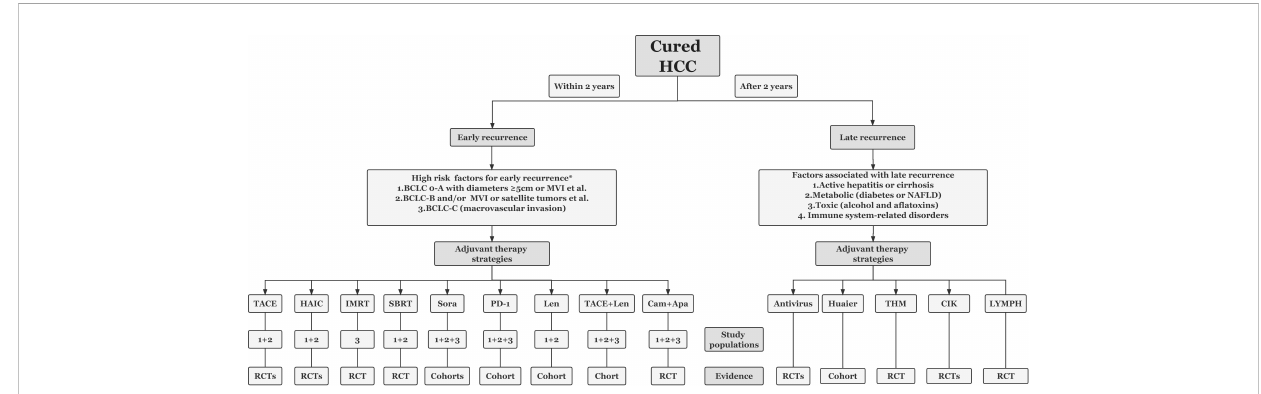
FIGURE 1 A quick overview of available adjuvant treatment strategies for populations with different risk factors for recurrence. *There are no standardized criteria for high-risk recurrence factors which generally determined by tumor characteristics and highly aggressive pathological features, and highly aggressive pathological features generally refer to poor differentiation, satellite lesions, and microvascular invasion. TACE, transarterial chemoembolization; HAIC, hepatic artery infusion chemotherapy; IMRT, intensity modulated radiotherapy; SBRT, stereotactic body radiotherapy; Sora, sorafenib; PD-1, programmed death protein 1 inhibitors; Len, Lenvatinib; Cam, camrelizumab; Apa, apatinib; NAFLD, non-alcoholic fatty liver disease; THM, traditional herbal medicine; Huaier, huaier granules; CIK, cytokine induced killer cells; LYMPH, lymphocyte